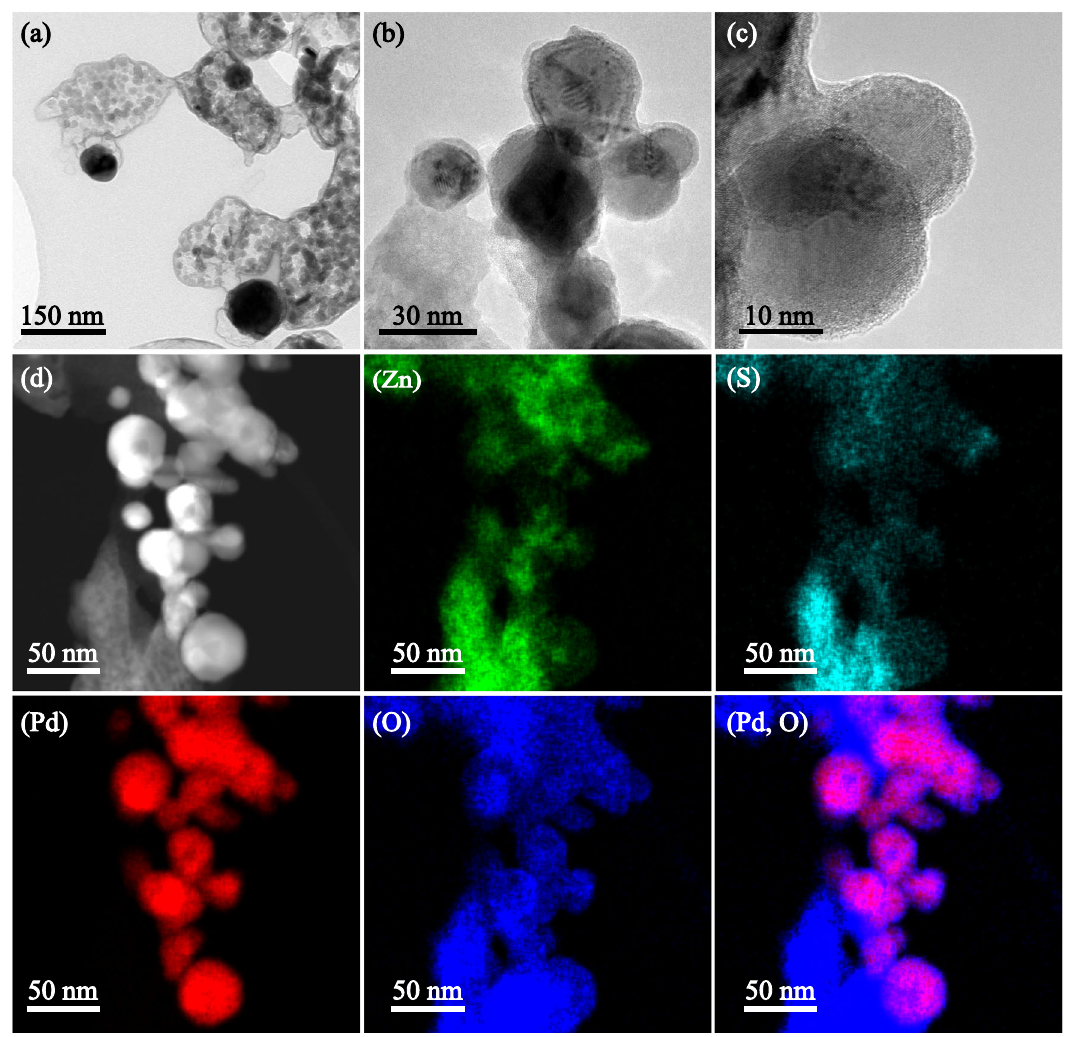
Fig. 3 | TEM observation of 1.1mol% Pd-doped ZnSO 4 catalyst. Panel a for the low-magni fi cation TEM picture. Panels b , c for the high-magni fi cation TEM for Pd clusters and individual Pd particles. Panel d for the STEM observation of catalyst